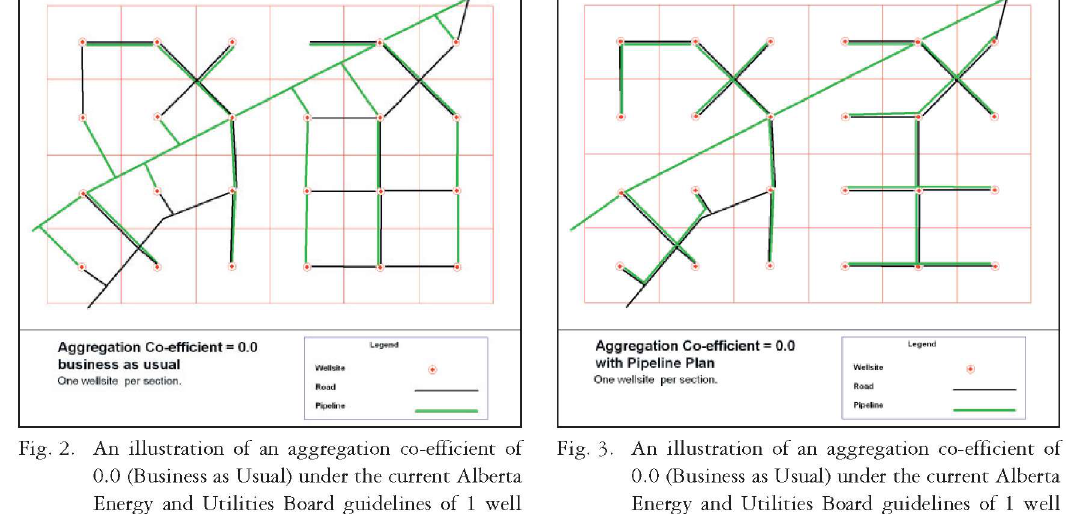
Fig. 2. An illustration of an aggregation co-efficient of 0.0 (Business as Usual) under the current Alberta Energy and Utilities Board guidelines of 1 well per mi 2 (2.59 km 2 ).